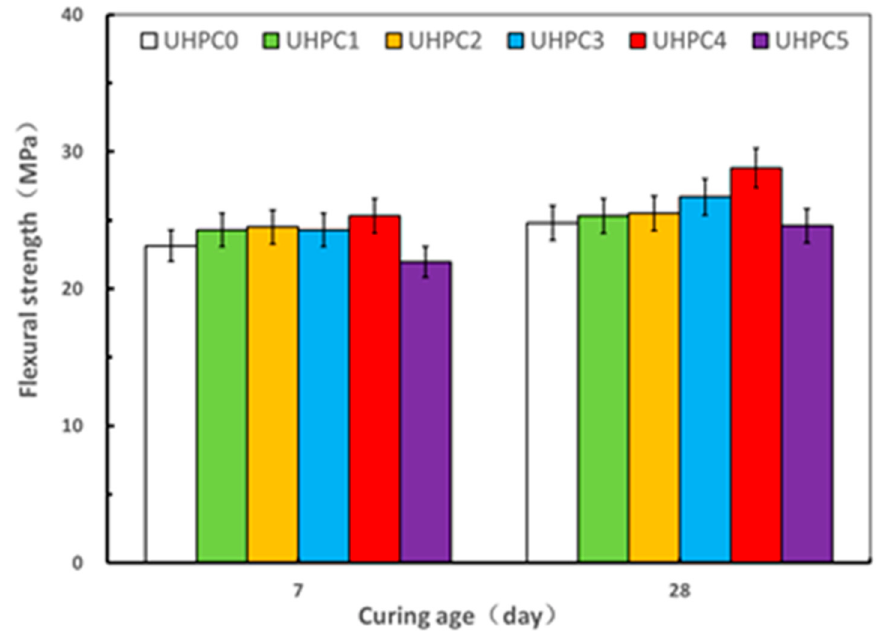
Figure 8. E ff ect of GO nanosheets on flexural under steam Figure 8. Effect of GO nanosheets on flexural under steam curing.